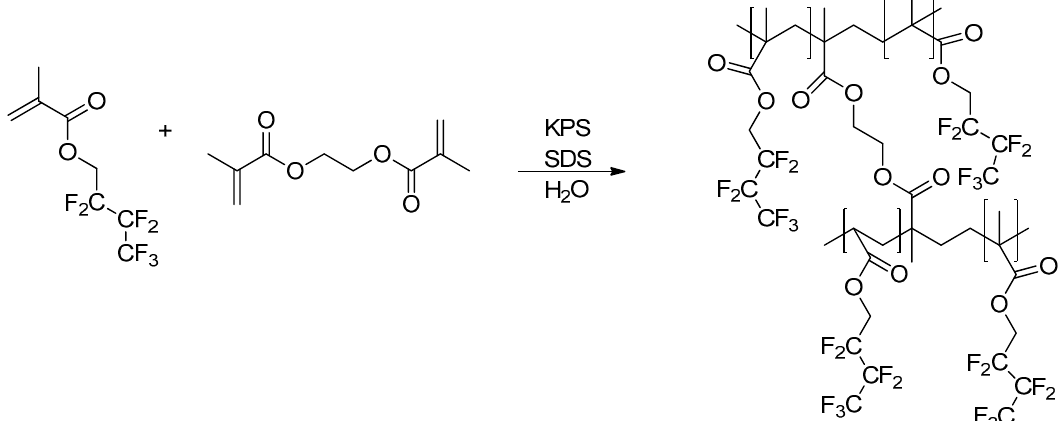
Figure 5. Schematic of HFBMA polymerization, in the presence of ethylene glycol-di-methacrylate (EGDMA).